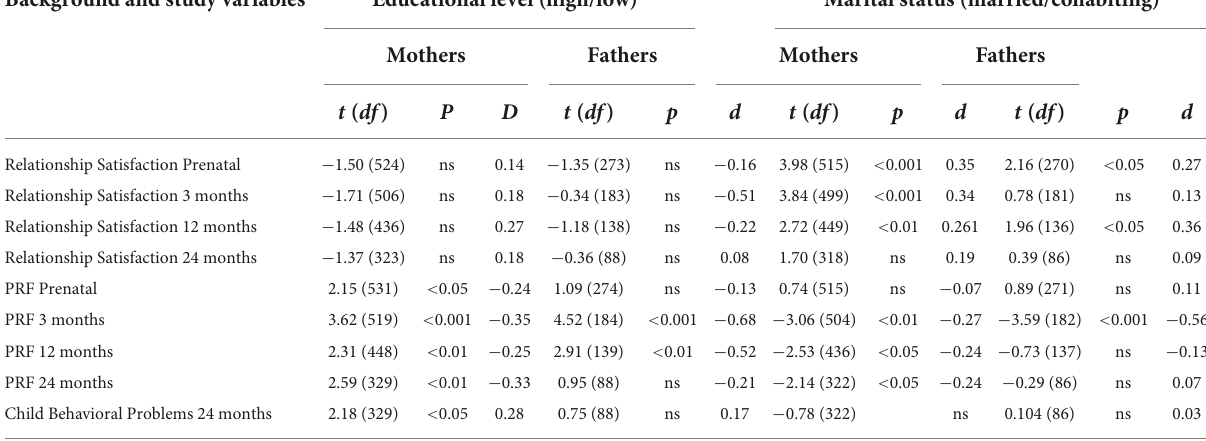
TABLE 3 Associations between the background and study variables for mothers and fathers.